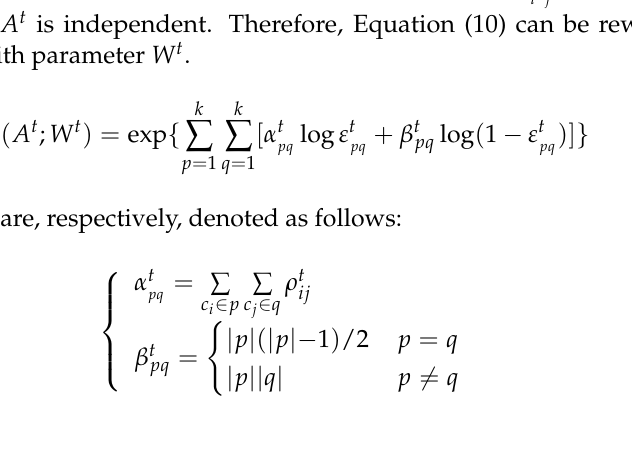
Figure 3. Randomly sample ( , ) ij and allocate  with probability